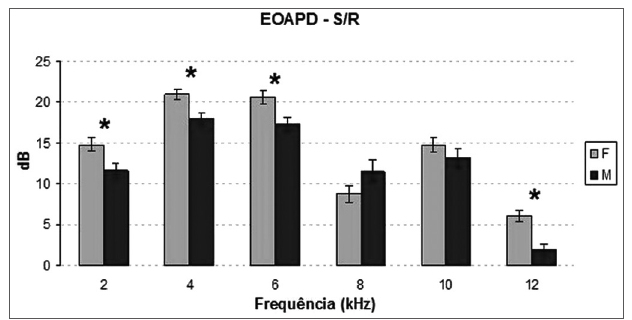
Figura 7. Média e desvio padrão das relações sinal/ruído das EOAPD registradas para cada gênero em cada frequência. F: Feminino, M: Masculino. Teste ANOVA, p <